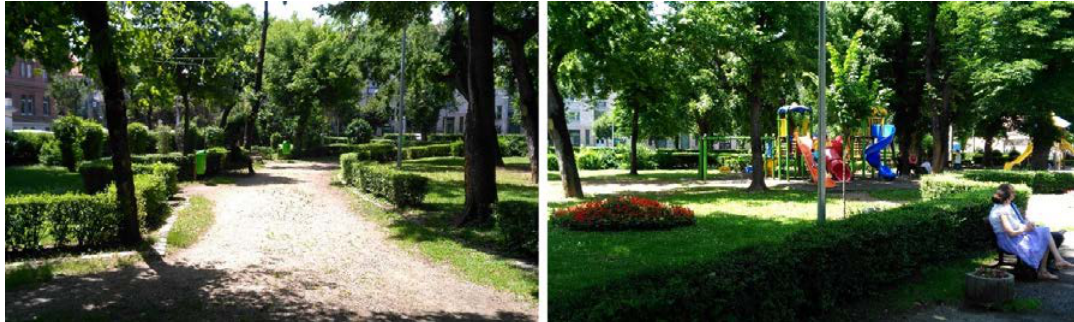
Figure 1 3 : Pedestrian walkway made of ground and gravel. Playground equipment for children Source: Emanuel- Cristian ADOREAN, 2016©